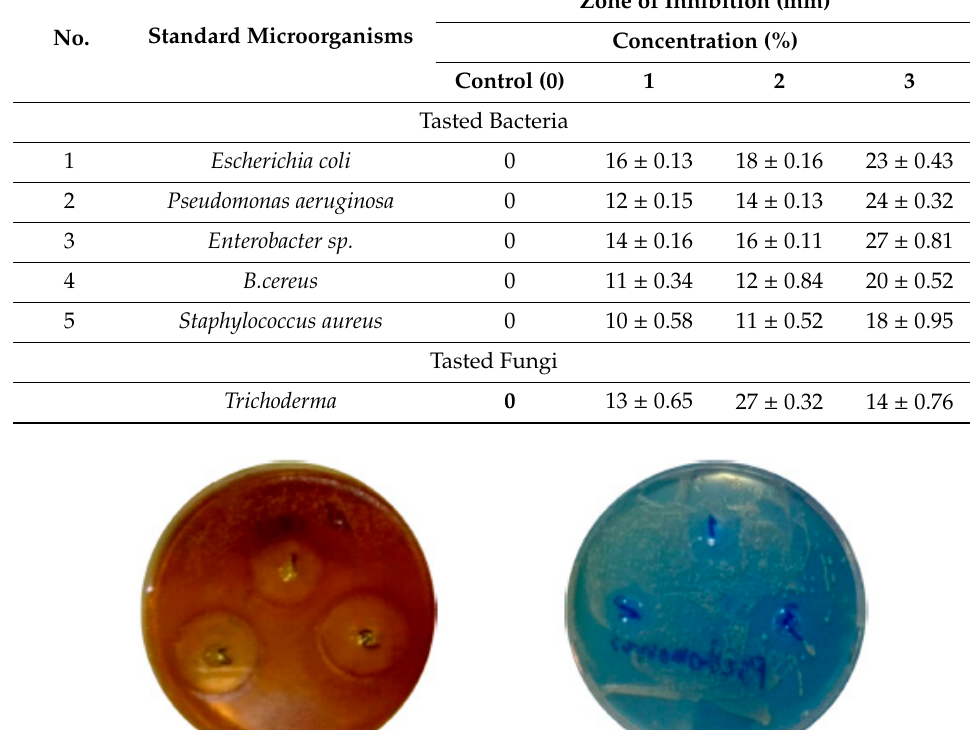
Table 4. Antimicrobial activity of the MS edible film incorporated with CEO.